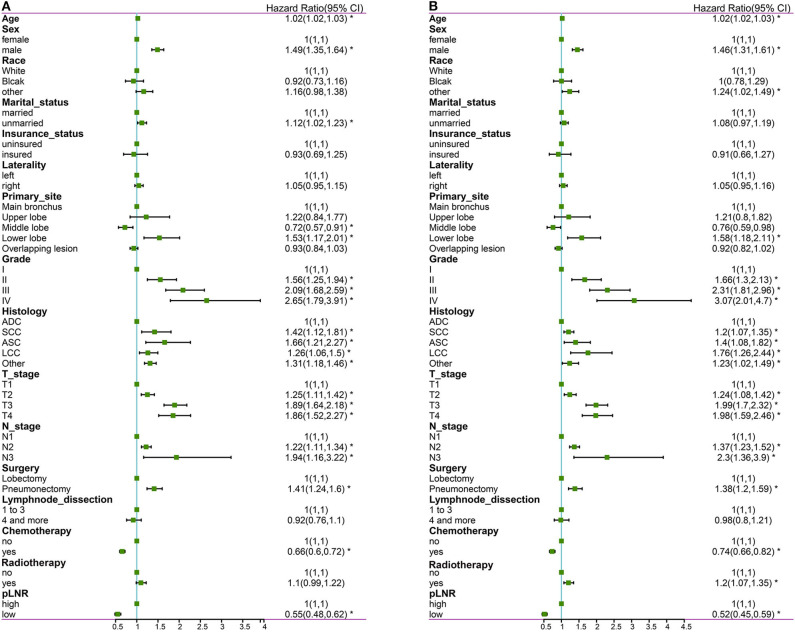
The forest map of Cox regression analysis. Univariate Cox regression analyses estimating the risk factors for OS (A) and CSS (B). OS, overall survival; CSS, cancer-specific survival. *Means P < 0.05.